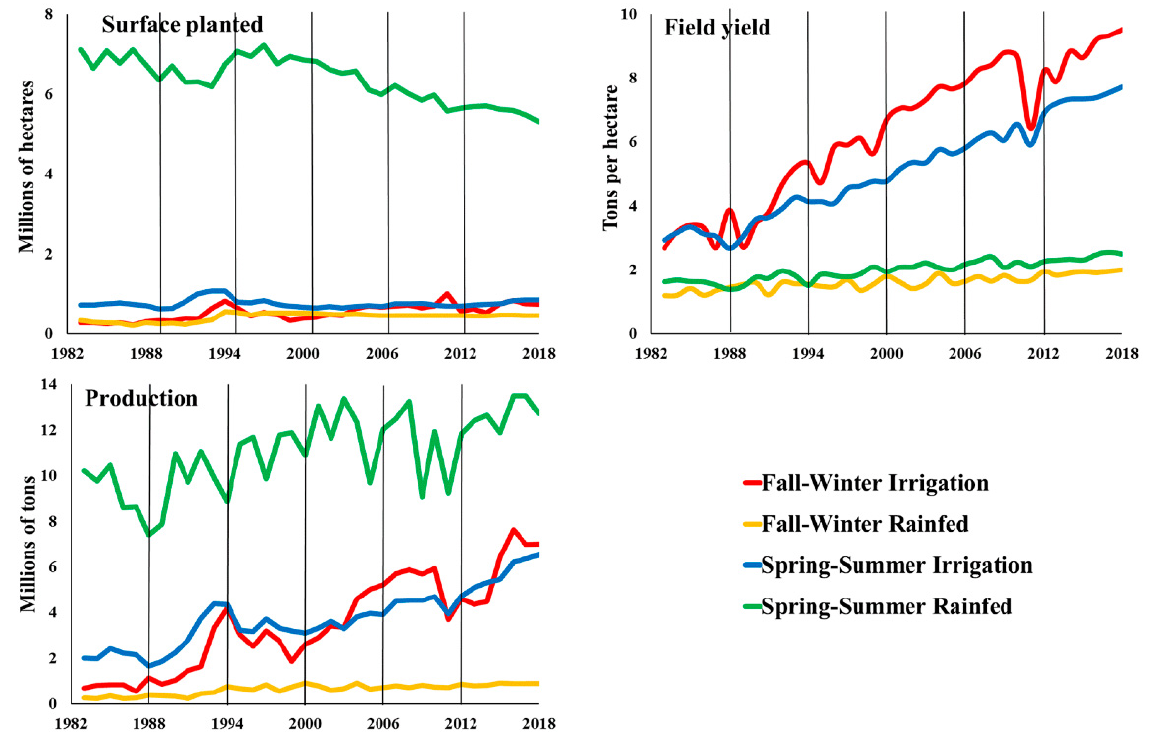
Figure 2. Temporal evolution of the surface planted, field yield, and grain maize production in Mexico from 1983 to 2018, per production cycle and water regime.